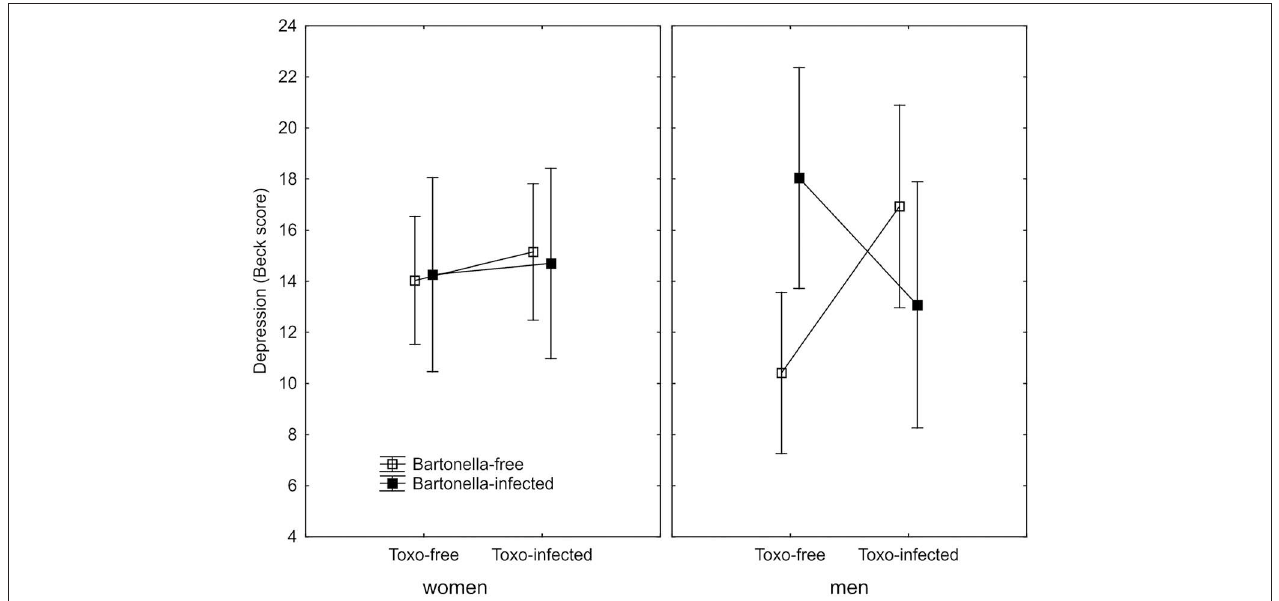
FIGURE 2 | Association of Bartonella and Toxoplasma seropositivity with BDI-II depression score. Squares show depression computed for covariates at their means and spreads 95% confidence